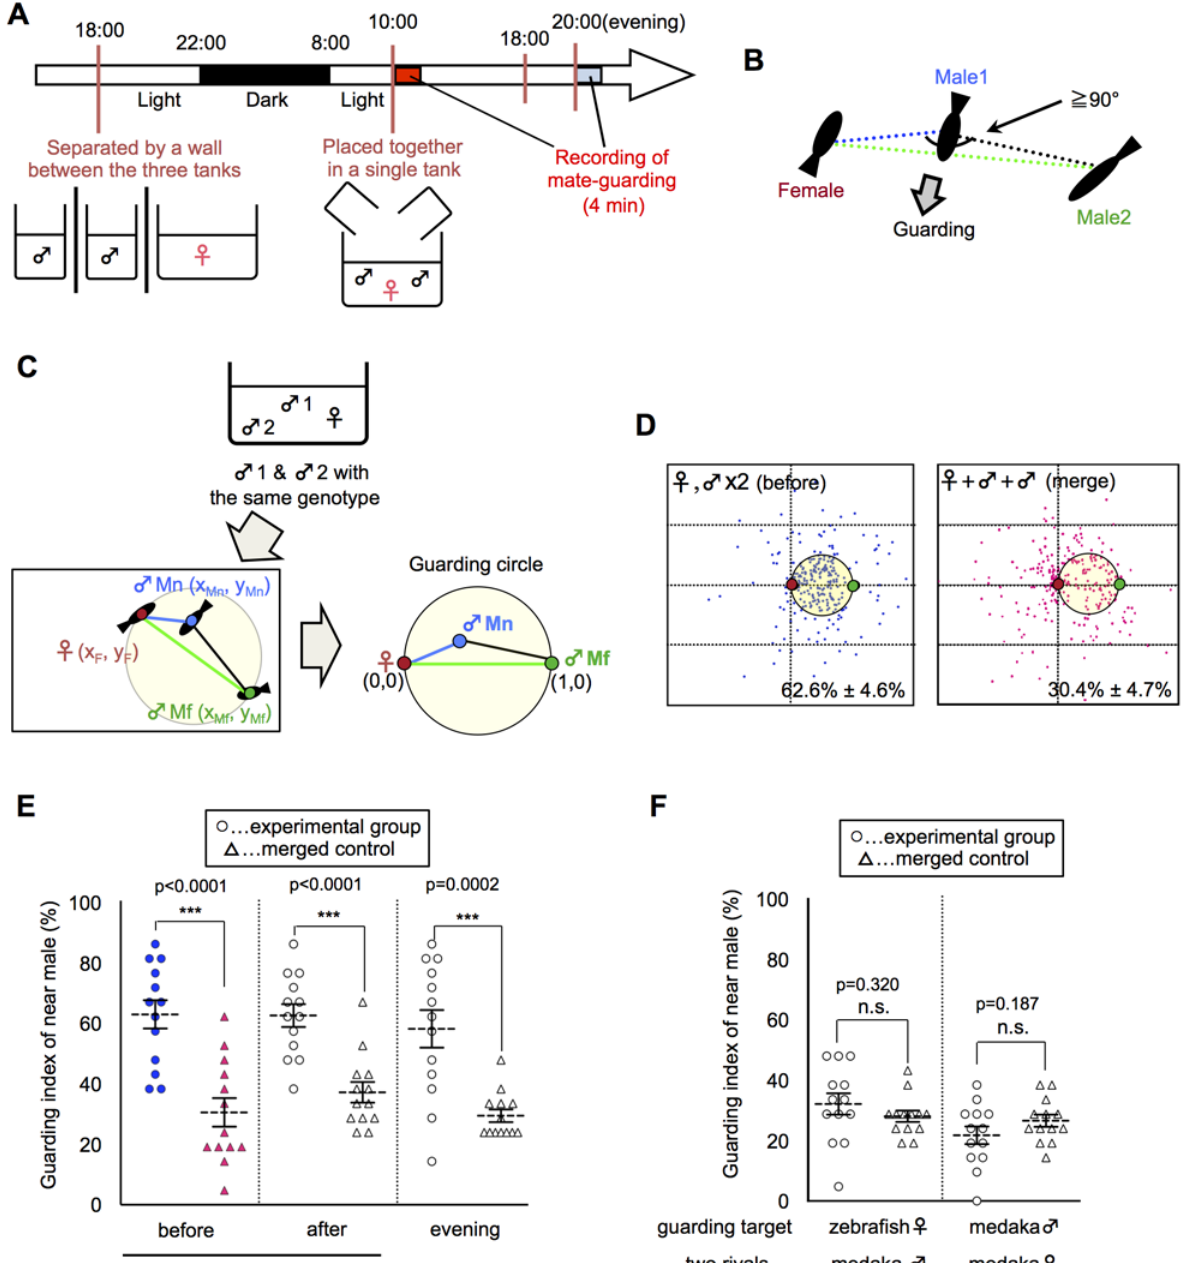
Fig 1. Emergence of mate-guarding in a triadic relationship. (A) Time-course for the mate-guarding behavior observation. One female and two males were placed in an aquarium in the morning (~10:00) or in the evening (~20:00). Lights were turned off at 22:00. (B) One example of typical mate-guarding behavior. One male tended to maintain its position between the female and the other male and prevent that male from approaching the female. We defined this behavior as “ mate-guarding behavior ” . (C) A procedure for calculating the guarding index representing the degree of mate-guarding. As fish with the same genotype were used, we discriminated the two male fish according to the mean distance for 100 s from the female (near male and far male). We measured the relative locations of the three fish and calculated the probability of the near male being in the guarding circle with center (1/2, 0) and radius 1/2 when the female and far male positions were defined as (0, 0) and (1, 0), respectively. We defined this probability as the “ guarding index of the near male ” and compared the groups in the guarding test. (D) Relative positions of the three fish (one female and two males). Dots indicate the relative positions of the near male over 100 s (1 dot/5 s). Red and green small circles indicate positions of the female and far male, respectively. Guarding indices are shown in the lower right. “ Merge ” indicates superimposed data of three fish moving independently, and thus were used as a negative control. Each n = 21 dots x 13 trials. (E) Comparison of guarding indices of the near male in the experimental group with those in the merged control to examine the effect of female condition on